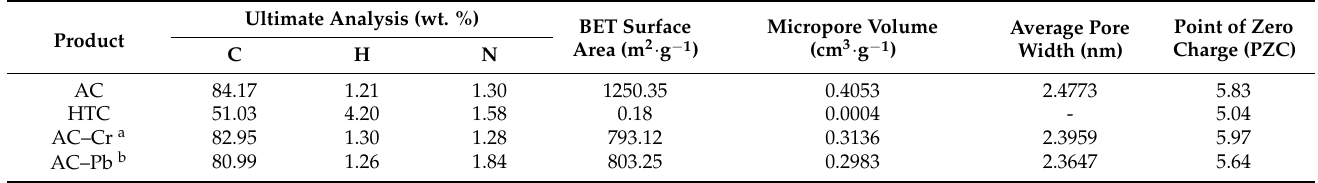
Table 1. Ultimate analyses and characteristic of AC, HTC, as well as AC after Pb(II) and Cr(VI) adsorption.